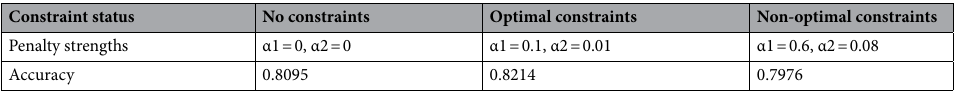
Table 1. Comparing accuracy and constraint strength. The effect of different penalty strengths on the classification accuracy of the LYRIKS dataset (accuracy using top 8 genes ).